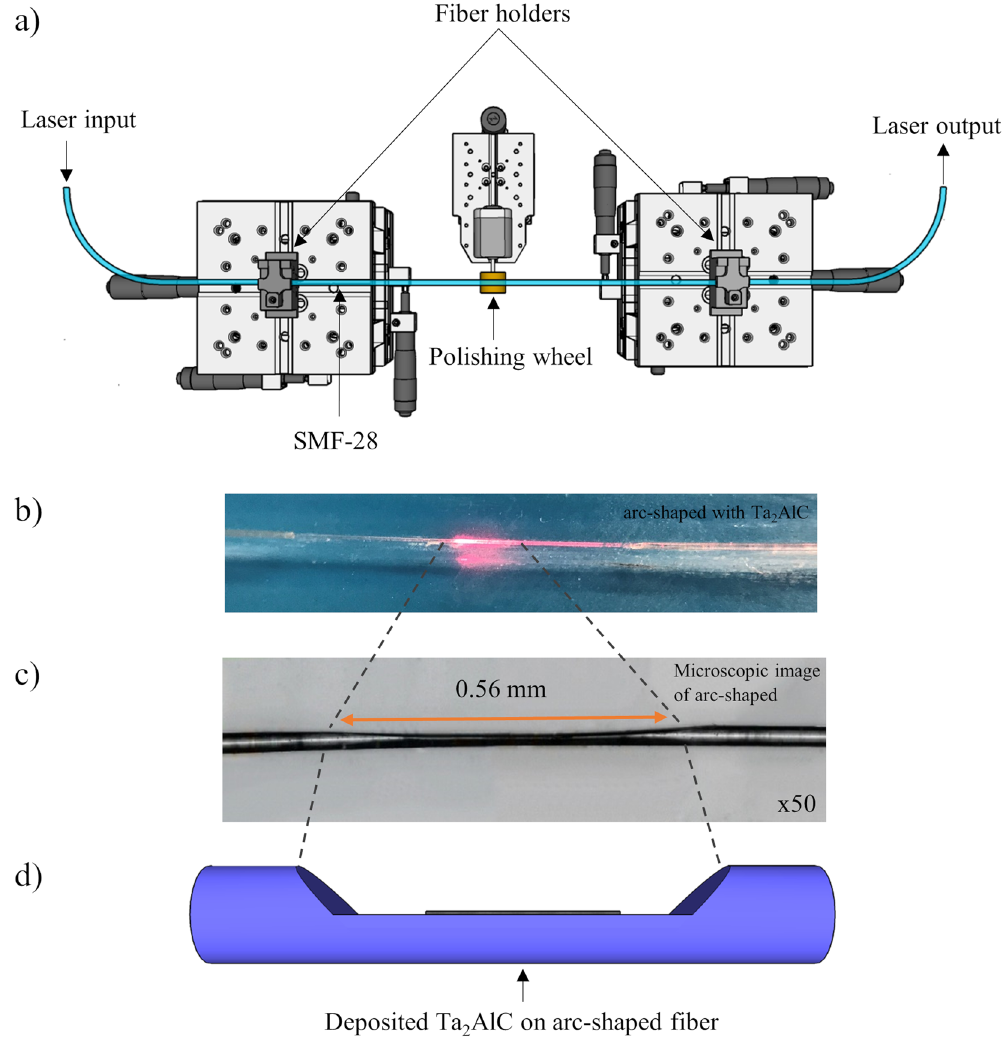
Figure 8. ( a ) Schematic illustration of wheel polishing method to fabricate the arc-shaped fiber. ( b ) The interaction of the arc-shaped fiber embedded with the Ta 2 AlC nanoparticles when a red-light source was injected. ( c ) The microscopic image of the side profile of the arc-shaped fiber at × 50 magnification. ( d ) The illustration of the deposited Ta2AlC onto the arc-shaped fiber. ( a ) Drawn using SketchUp Make 2017 (Basic), Software Version: Windows 64-bit 17.2.2555, Available at https:// www. sketc hup. com/ downl oad/